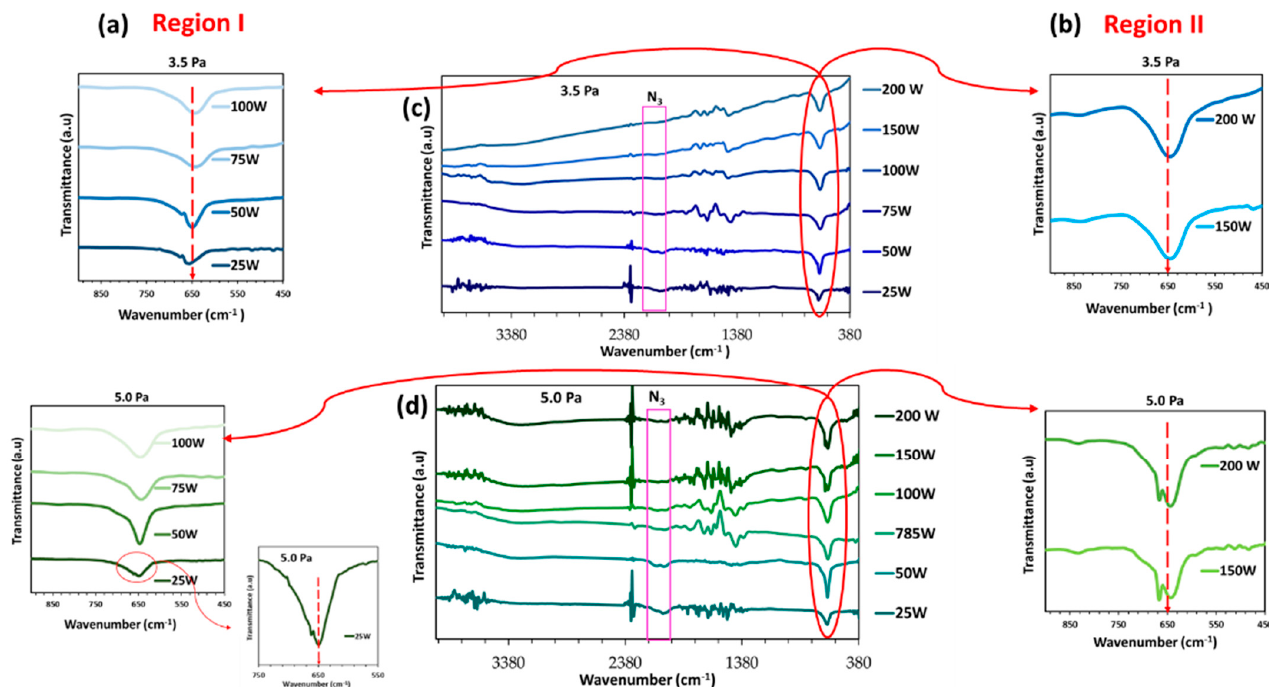
Figure 7. FTIR spectra of Cu 3 N films prepared at different RF power and gas pressures of 3.5 Pa and 5.0 Pa for samples in ( a ) region I and ( b ) region II. The whole spectra of the samples are pictured in ( c , d ).